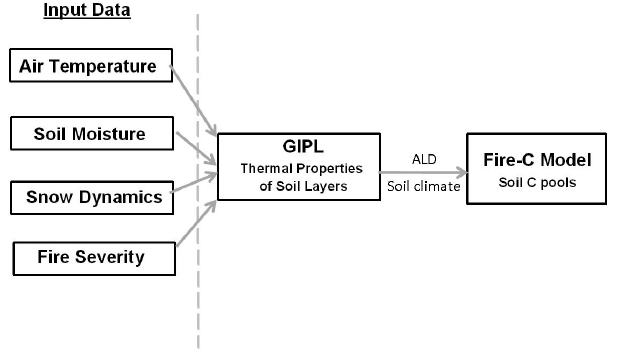
Fig. 1. The modeling framework of this study in which the Geo- physical Institute Permafrost Laboratory (GIPL) model was cali- brated from measured temperature input data. GIPL was then used to simulate active layer depth (ALD) and soil temperature profiles over a variety of climate and soil conditions. The Fire-C model used GIPL results to simulate changes in soil OC storage over mul- tiple fire cycles based on ALD and soil temperature (August mean monthly temperature). Input data include air temperature, soil mois- ture, snow depth and fire severity (carbon fraction combusted during a fire event) from the Hess Creek study area collected from 2007– 2009 . Sensitivity analyses were conducted (see Table 1 for scenario details) using the GIPL model to assess the impact of input variables on ALD and soil temperatures. ALD and soil temperature data were then used to drive soil C turnover in the Fire-C